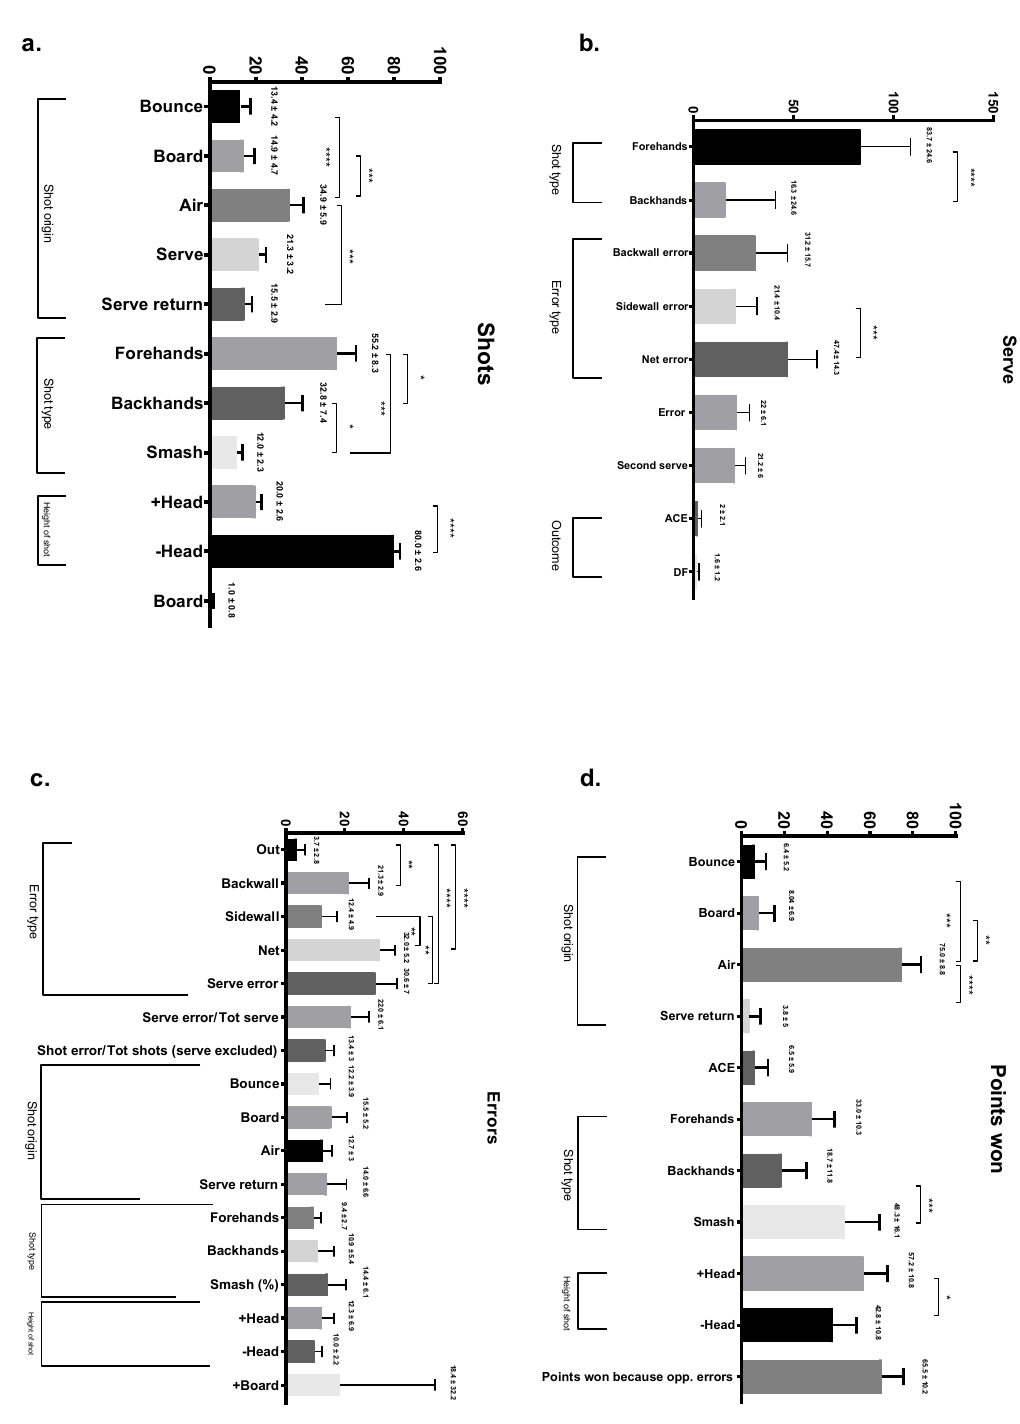
Figure 1. Characteristics of shots ( a ), serve ( b ), errors ( c ) and points won ( d ). Data are expressed as mean percentage ± standard deviation. * p ≤ 0.05; ** p ≤ 0.01; *** p ≤ 0.001; **** p ≤ 0.0001.